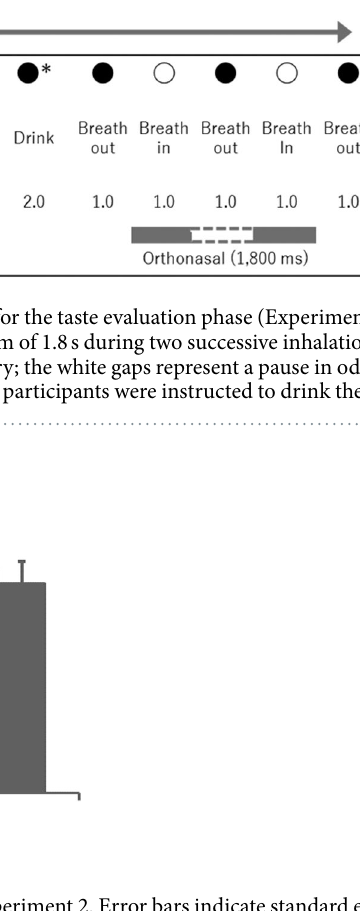
Figure 6. Mean ratings of taste intensity for Experiment 2. Error bars indicate standard error (n = 8). A two- way ANOVA showed that the main effect of solution was significant (F (1, 7) = 293.3, p = 0.0000006, η p2 = 0.98), but the main effect of odor and the interaction between factors were not